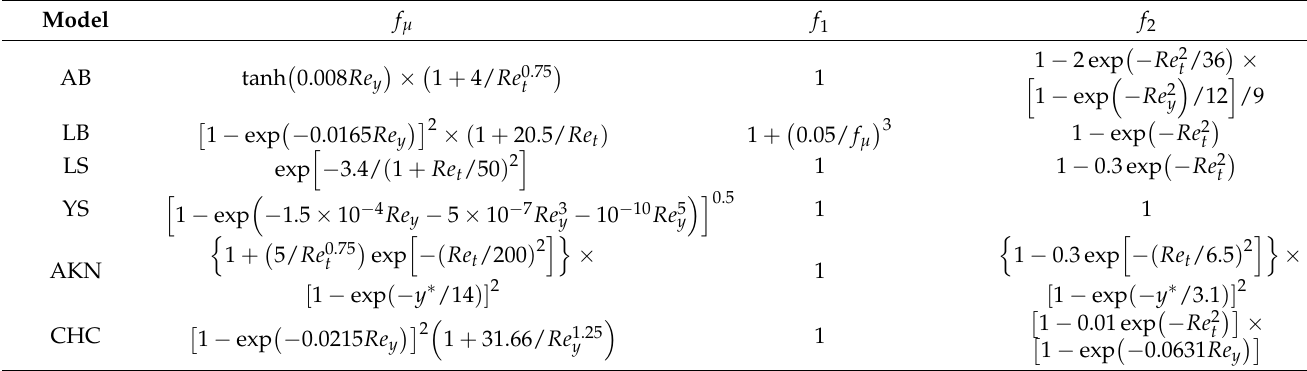
Table 2. Damping function in governing